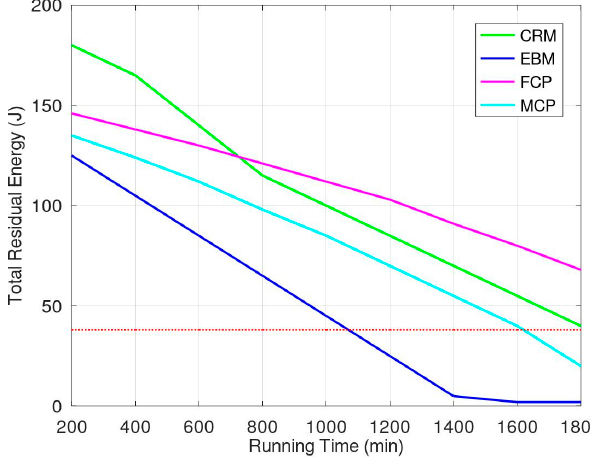
Figure 8. Energy evaluations related to our proposed mechanism and two previous mechanisms.